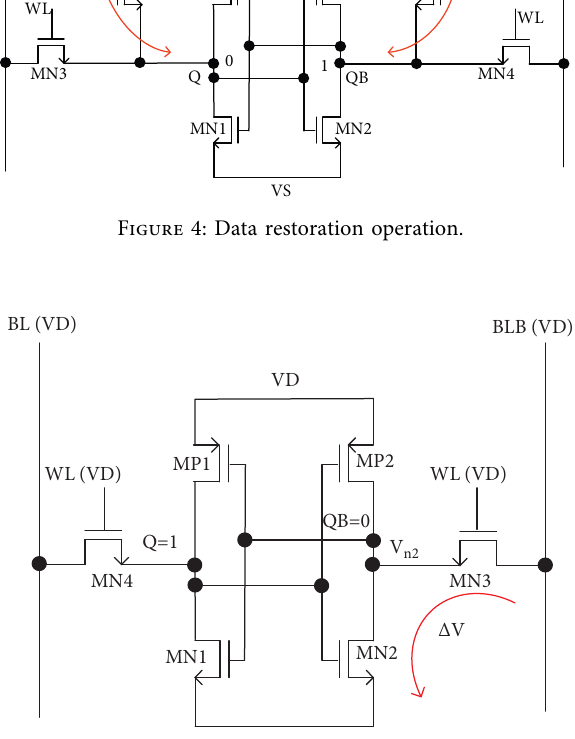
Figure 5: Read operation.